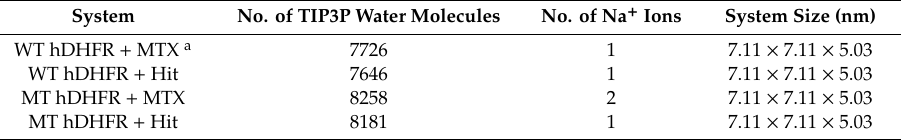
Table 4. The specifications of four systems used for molecular dynamics simulations.